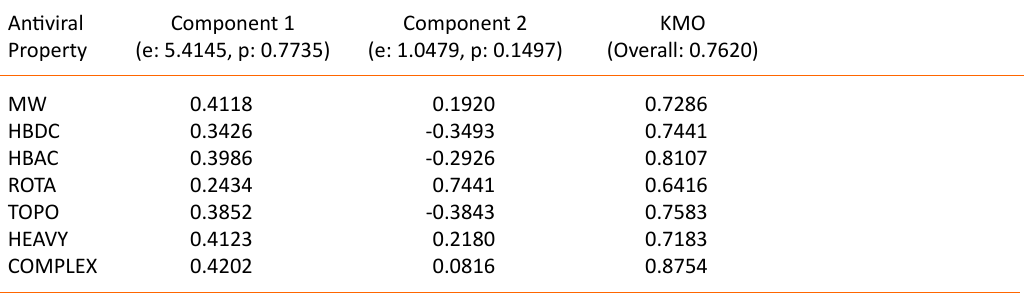
Table 2. Eigenvector loading values, eigenvalues, and measure of sampling adequacy Antiviral Component 1 Component 2 KMO Property